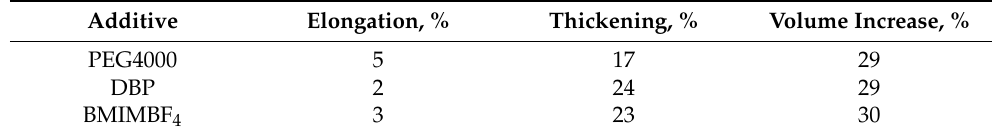
Table 5. Electrode film parameters changing during impregnation.